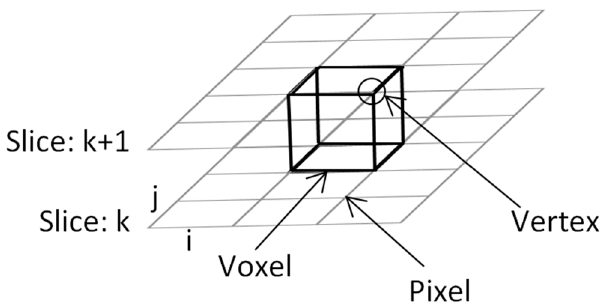
Figure 4. The connection of vertices to form the cube.